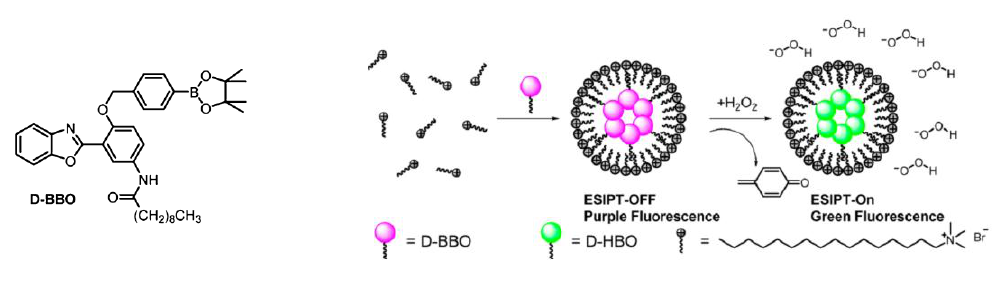
Figure 5. Structural formula of D-BBO and proposed mechanism for the detection of H 2 O 2 , based on an excited-state intramolecular proton transfer (ESIPT) process. Reprinted with permission from [17]. Copyright (2013) American Chemical